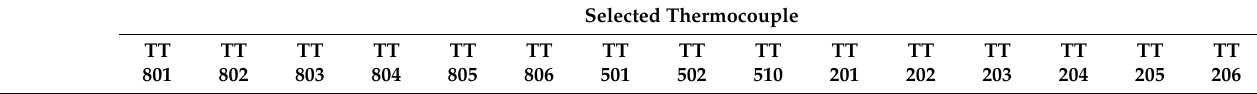
Table A1. Temperatures measured by selected thermocouples inside the blocks IA and KB at the different interrogation dates of the embedded DOFS instrumentation. Designation numbers of the thermocouples are the same as those presented in Figure 3. Greyed-out dates correspond to periods of immersion of the blocks in the pool.